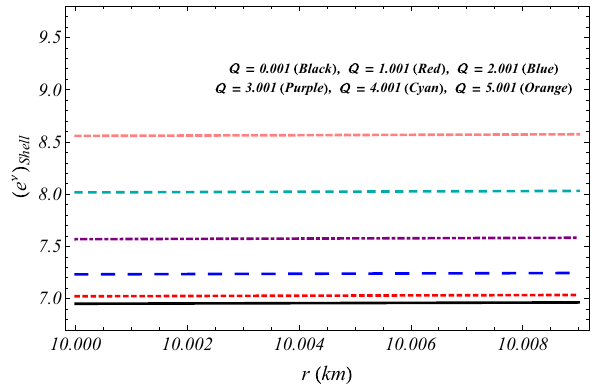
Fig. 1 The metric coefficient e ν inside the thin